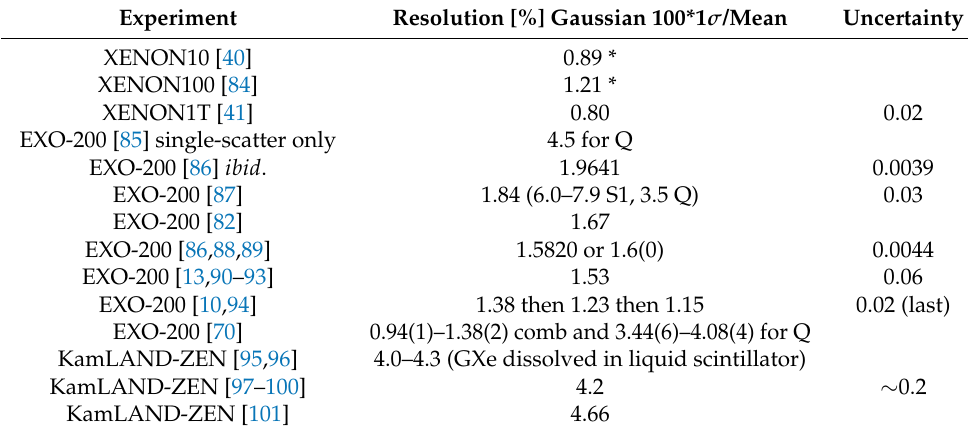
Table 1. Survey of experimentally achieved energy resolutions at Q ββ or very close to it (for instance, 2.6 MeV calibration). Entries marked with * are exceptions: extrapolations from power-law fits to much lower energies. Error bars are included whenever they were reported for the analyses. EXO made both hardware upgrades (Phase I, II) as well as many software